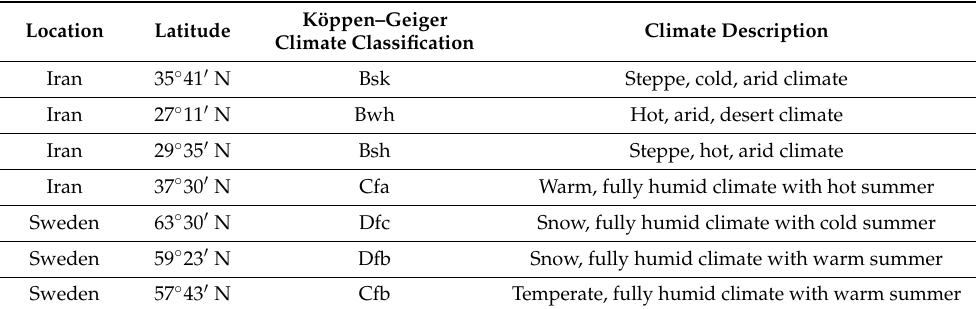
Table 1. Details of the locations and the major characteristic of their climate condition.